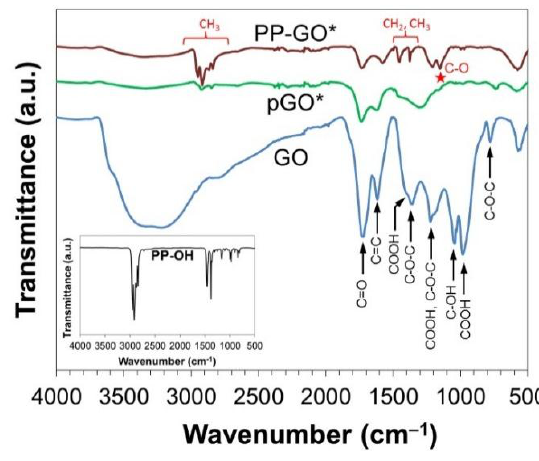
Figure 6. ATR-IR spectra of GO, pGO*, and PP-GO* samples.